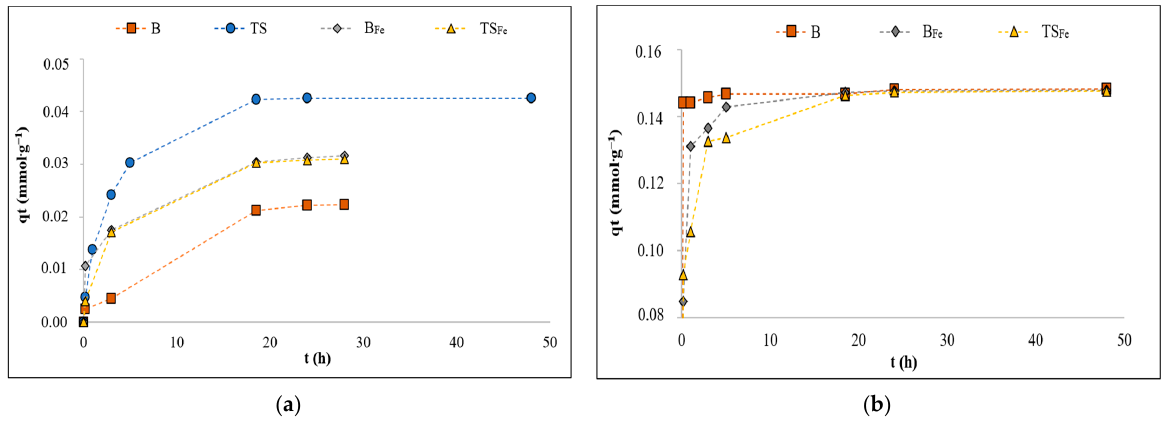
Figure 3. Adsorption kinetics of B/B Fe and TS/TS Fe for selected ions: ( a ) NH 4+ ; ( b ) PO 43 − .